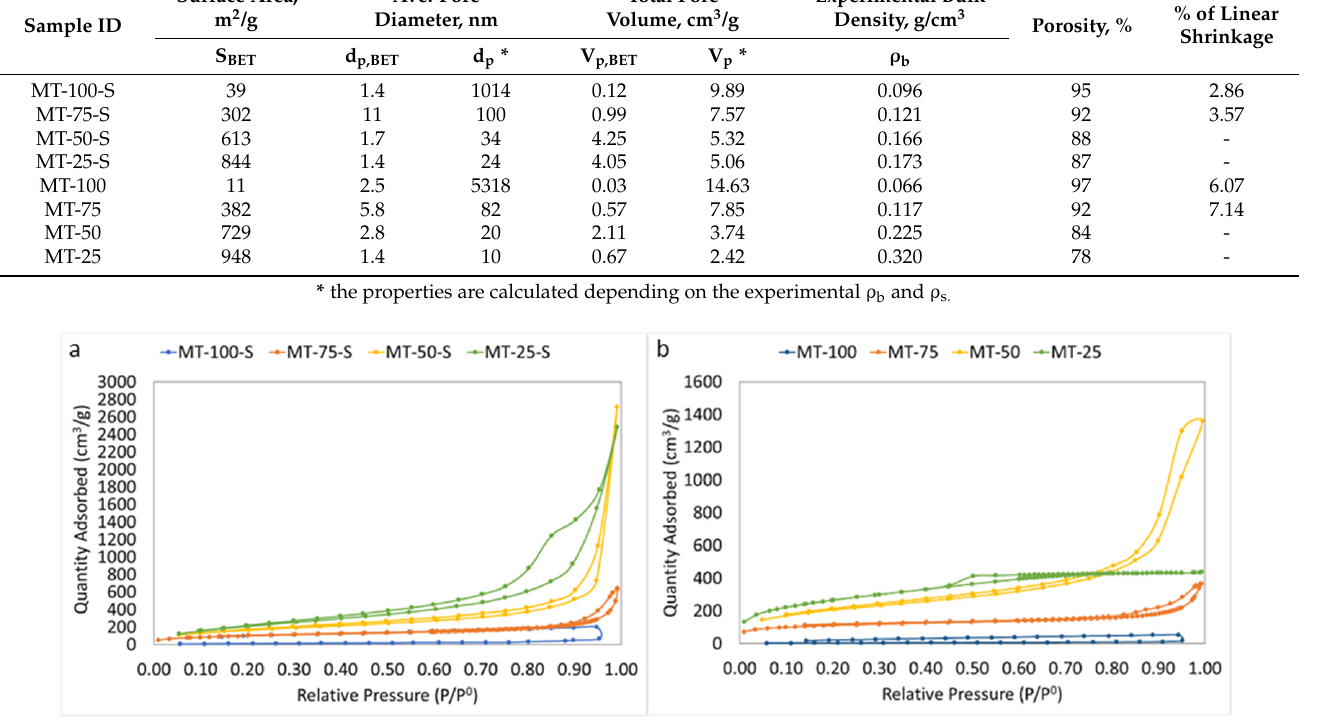
Figure 5. N2 adsorption–desorption isotherms of ( a ) silylated silica xerogels and ( b ) non-silylated silica xerogels.